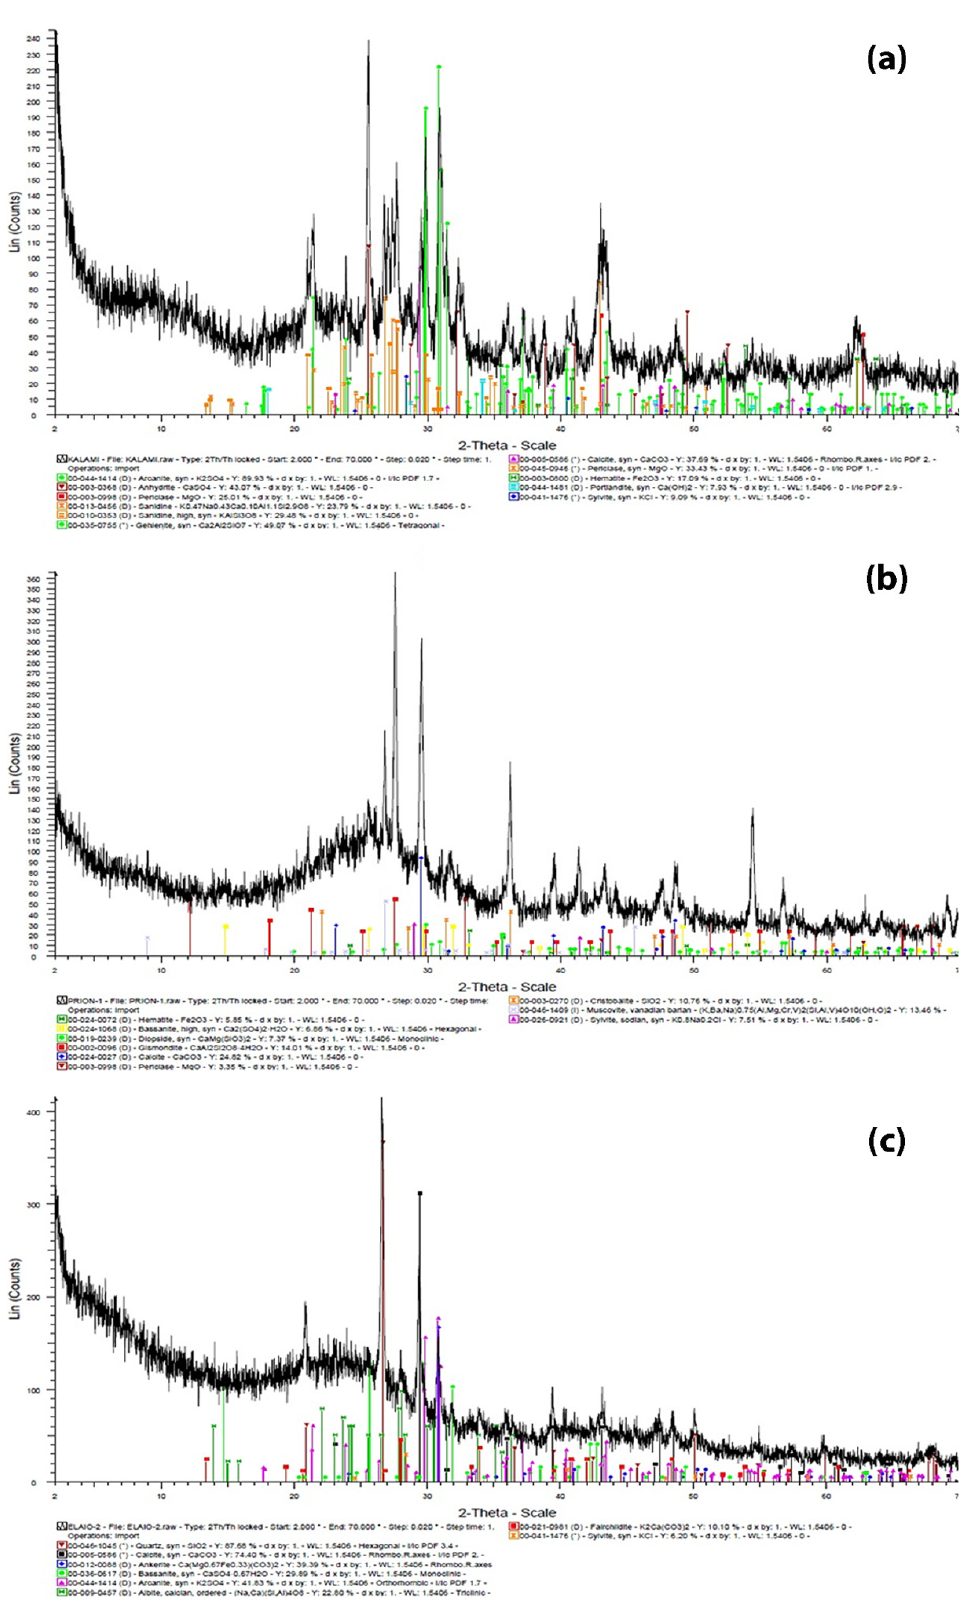
Figure 3. X-ray diffraction patterns of the biomass ash samples: ( a ) reed ash, ( b ) sawdust ash, ( c ) olive kernel residues